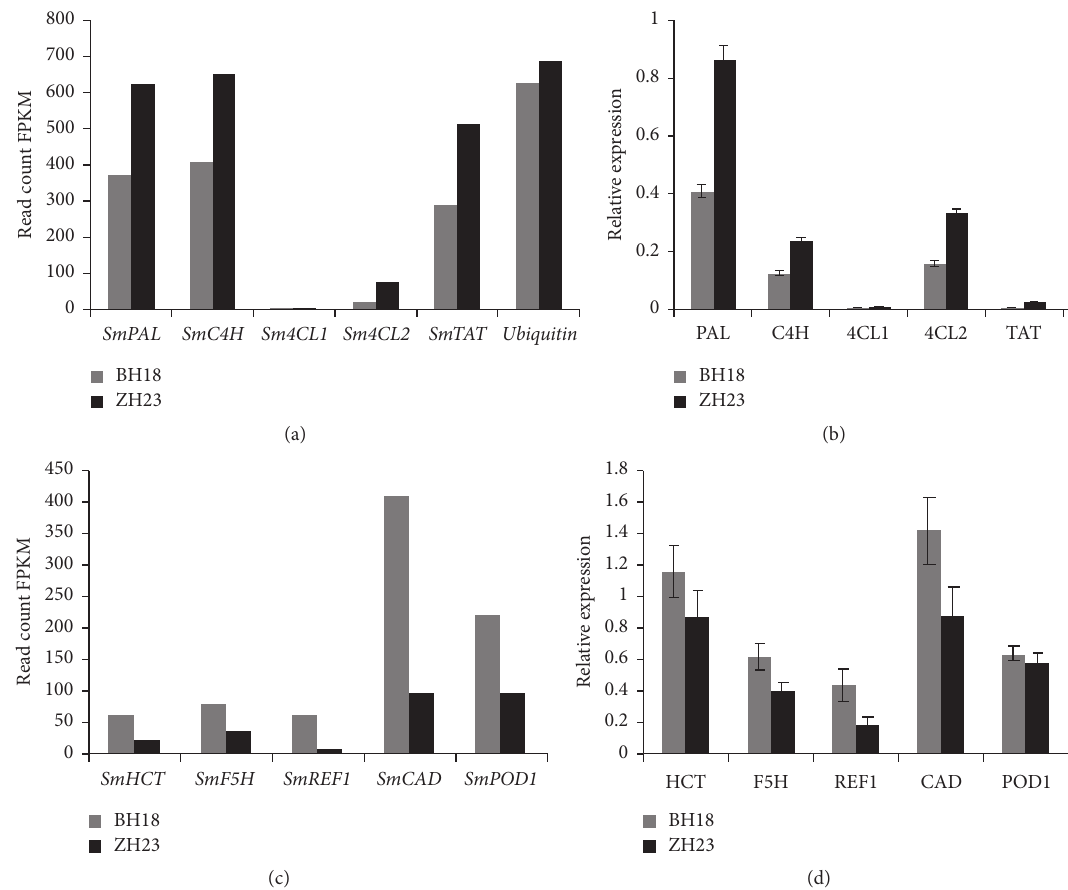
Figure 6: Expression patterns of the genes involved in phenolic acid biosynthesis in BH18 and ZH23 detected by DGE and validated by qPCR. (a) RA biosynthesis genes detected by digital gene expression (DGE). (b) The 5 genes selected from above were confirmed by qPCR. (c) Lignin biosynthesis genes detected by digital gene expression (DGE). (d) The 5 genes related with lignin biosynthesis genes confirmed by qPCR. The results represent the means ± standard deviations of experiments performed in